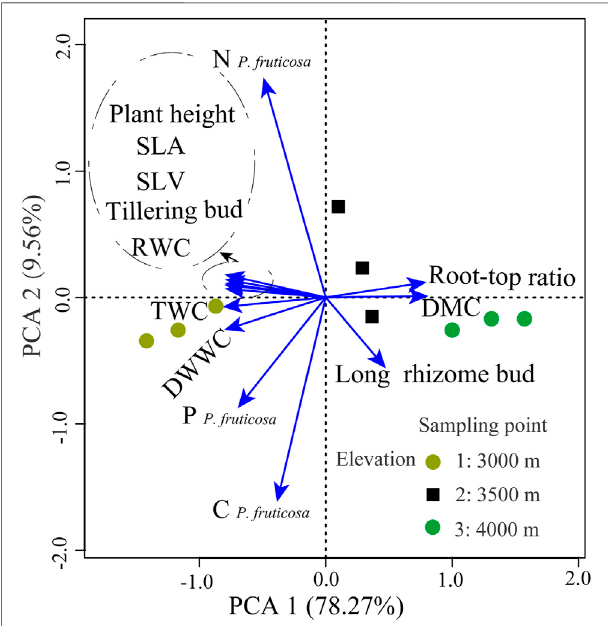
FIGURE 3 | Results of the PCA examining the distribution of plant trait variablesacrosstheexperimentalsite.Arrowsindicatedirectionsofloadingfor each variable. TWC, total water content; DWWC, dry weight water content; RWC, relativewatercontent;DMC, drymattercontent;SLA,thespeci fi c leafarea;SLV,speci fi clobevolume;C P.fruticosa ,leafcarbonconcentration;P 。 fruticosa , leaf phosphorus concentration; N P. fruticosa , leaf nitrogen concentration; Plant height, plant heightof P.fruticosa ;Root – top ratio,root to aboveground biomass ratio; Long rhizome bud, long rhizome bud of P. fruticosa ; Tillering bud, tillering bud of P. fruticosa